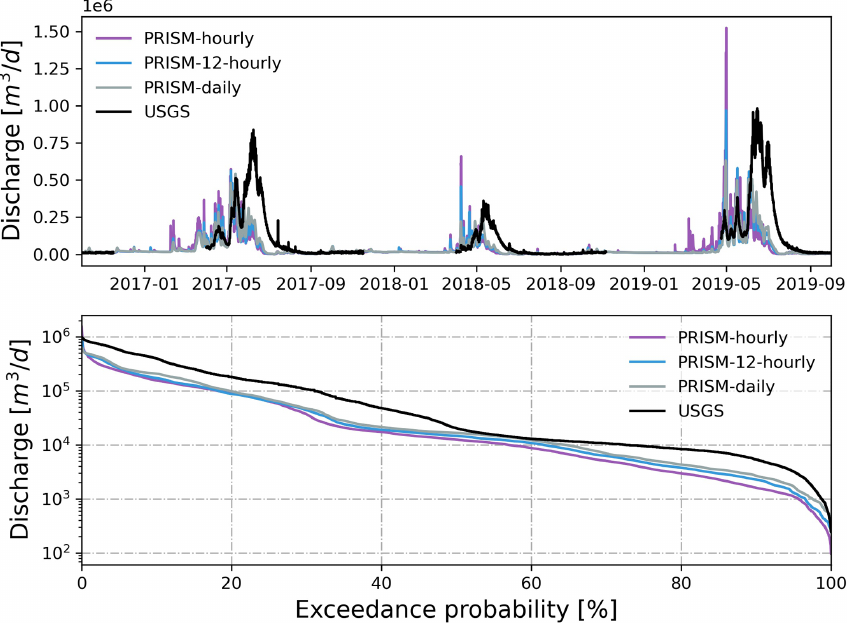
Figure 14. Simulated hourly discharge at the watershed outlet compared to hourly USGS streamflow under different temporal resolutions of PRISM. Also shown is the flow duration curve